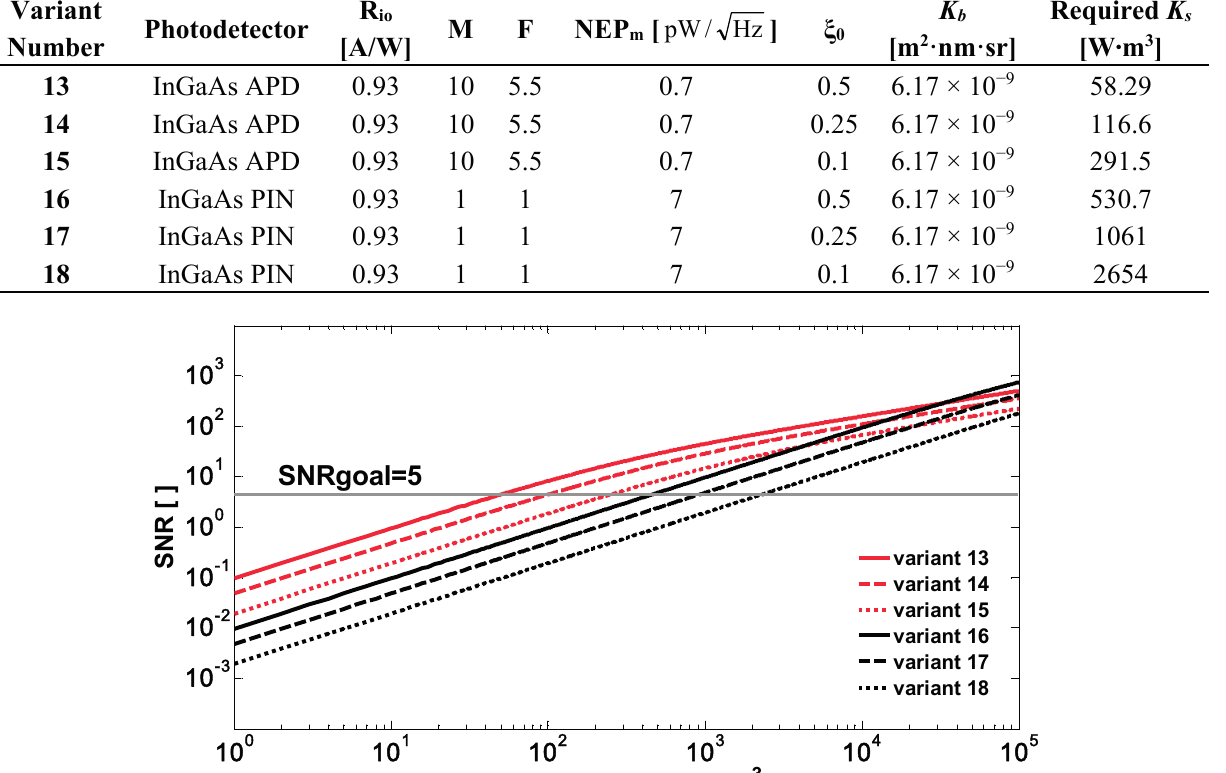
Table 4. Required system constant, K s , for various combinations of design parameters at 1.5 μ m.